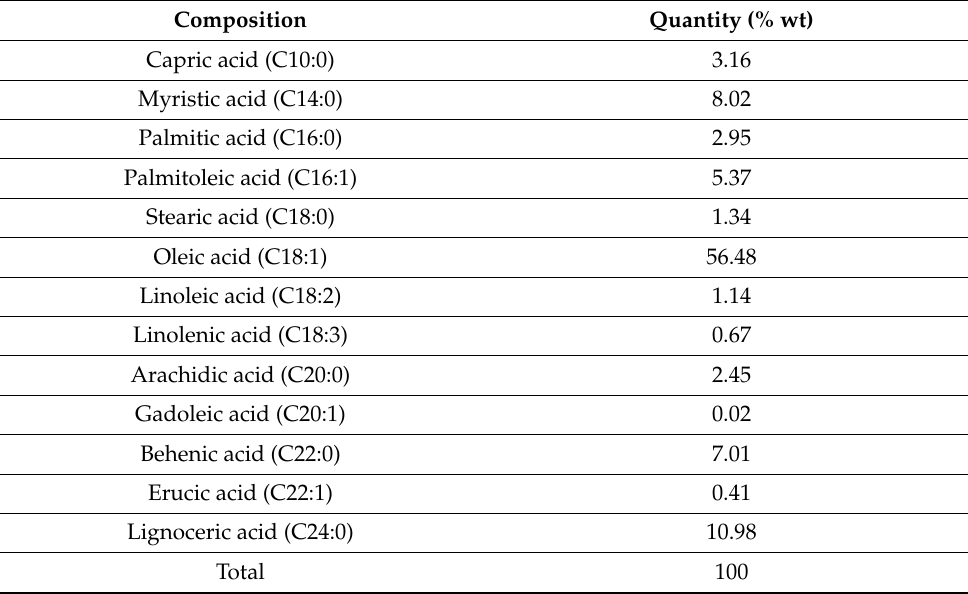
Table 2. Fatty acids composition of RBME obtained from direct transesterification.